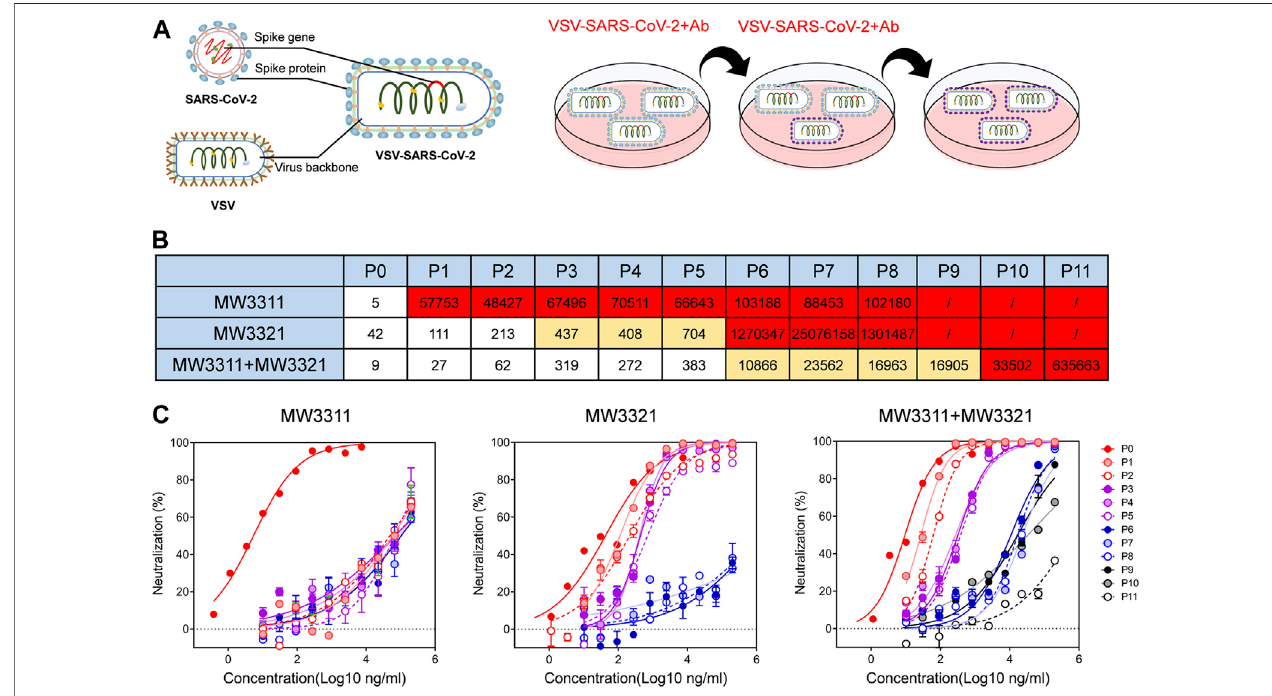
FIGURE2| EscapemutationanalysisofMW3321isaSARS-CoV-2pseudoviralsystem. (A) AschematicoftheSARS-CoV-2mutationalescapestudy.Replicating VSV-SARS-CoV-2 is constructed based on the recombinant virus VSV-bearing spike protein (S) gene of SARS-CoV-2. VSV-SARS-CoV-2 was passaged under the additive antibody pressure. (B) Heatmap showing the antibody neutralization potency against VSV-SARS-CoV-2 virus cultured at each passage. The IC 50 ( μ g/ml) value for each passage is shown with white, yellow, and red, indicating no escape (IC 50 < 400 ng/ml), partial escape (400 ng/ml < IC 50 < 2000 ng/ml), and complete escape (IC 50 > 2000 ng/ml), respectively (C) Neutralization curves of MW3311 (left panel), MW3321 (middle panel) and the cocktail of MW3311 with MW3321 (right panel). The data points are represented as mean ± SEM with n =